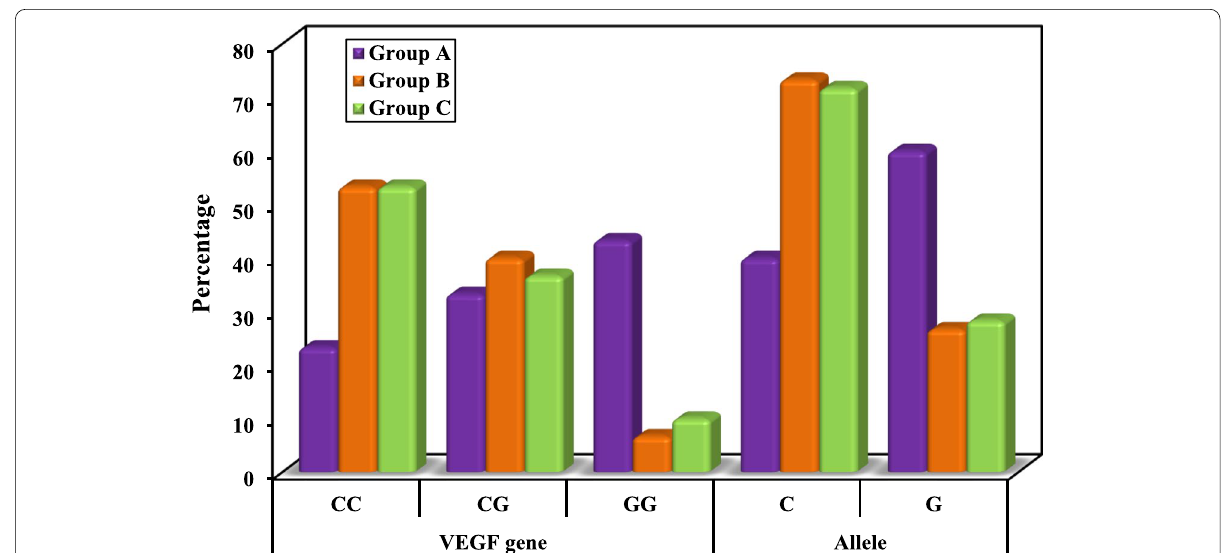
Fig. 1 Comparison between the three studied groups according to VEGF C(